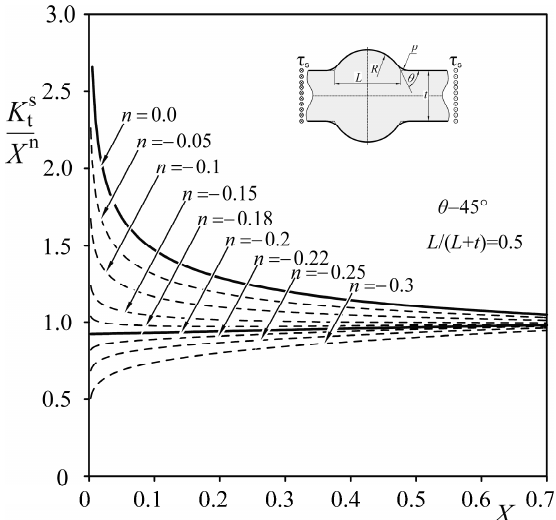
Figure 11. Influence of exponent n on the normalized K tt of a Double-V butt-welded joint under tension, when Y = 0.5 and θ = 75°.